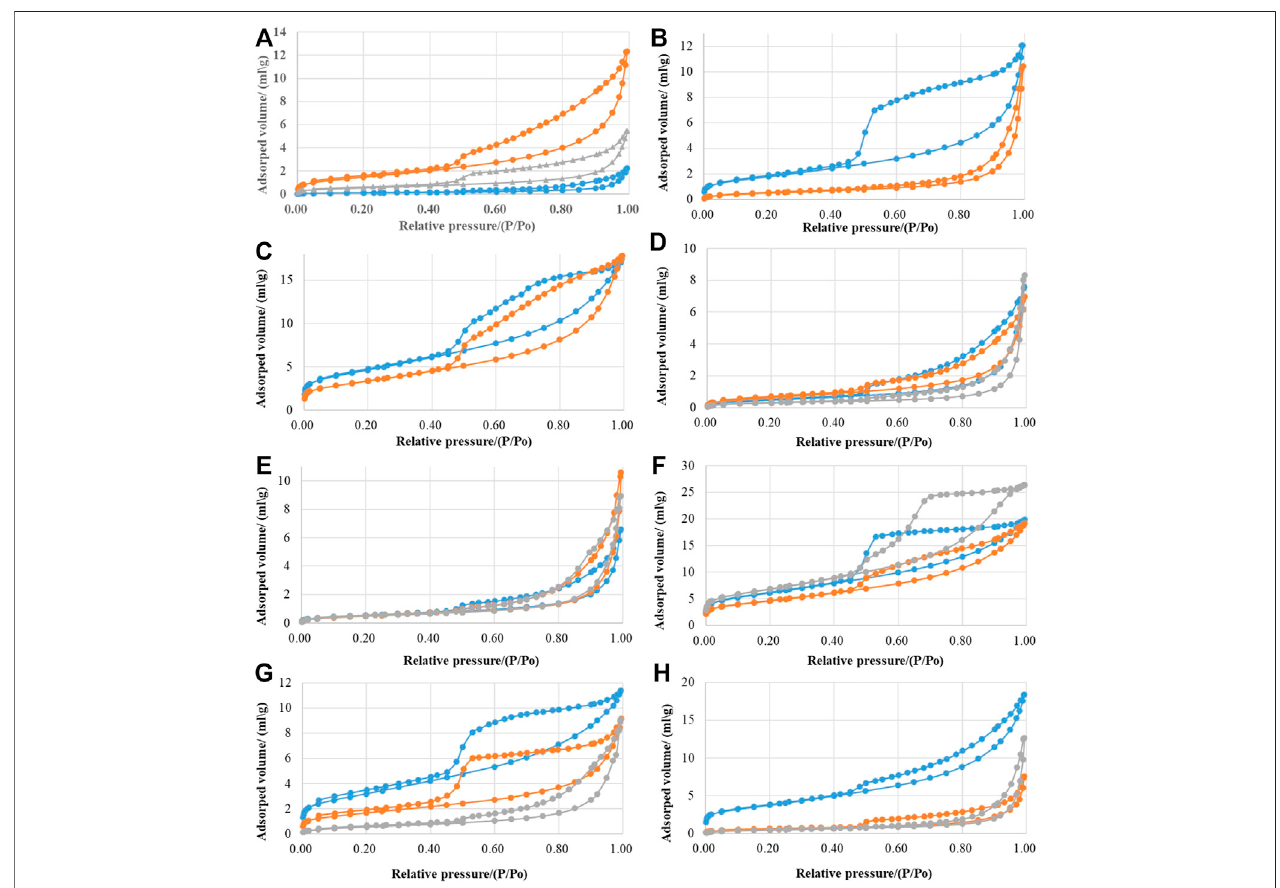
FIGURE 10 | Comparison of characteristics of nitrogen adsorption lines for samples of different lithofacies. (A) : Low organic matter (OM) — massive — carbonate shales. (B) : Medium to high OM — laminated — siliceous carbonate shales. (C) : Low to medium OM — layered — mixed carbonate shales. (D) : Medium to high OM — laminated — carbonate siliceous shales. (E) : Medium to high OM — massive — mixed siliceous shales. (F) : Medium to high OM — laminated — argillaceous siliceous shale. (G) : Low to medium OM — massive -mixed shale. (H) : Medium to high OM — laminated — mixed shale.